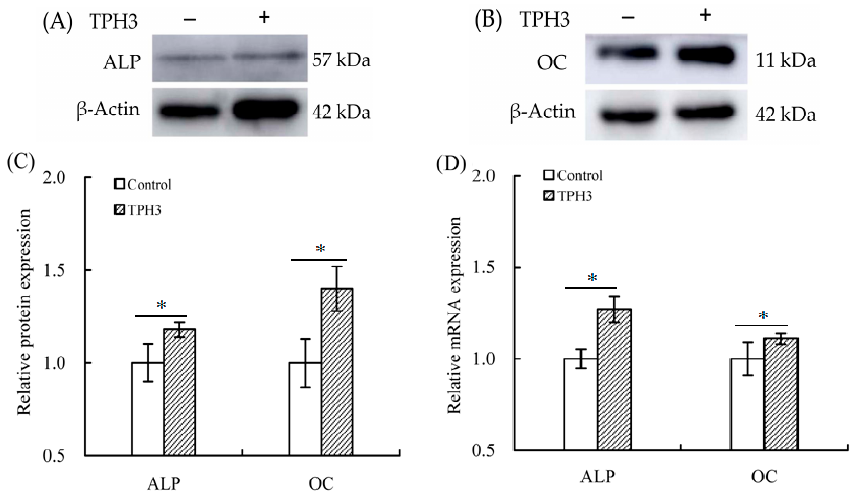
Figure 6. Expression changes of alkaline phosphatase (ALP) and osteocalcin (OC) in the osteoblasts exposed to TPH3. The cells were treated with vehicle or TPH3 (0.05 g/L) for 7 ( A ) and 21 ( B ) d, respectively. Relative protein expression of ALP and OC ( A , B ); protein expression changes of ALP and OC ( C ), and relative mRNA expression changes of ALP and OC ( D ). Expression of genes and proteins were normalized against β -actin. *: compared to control, p < 0.05.